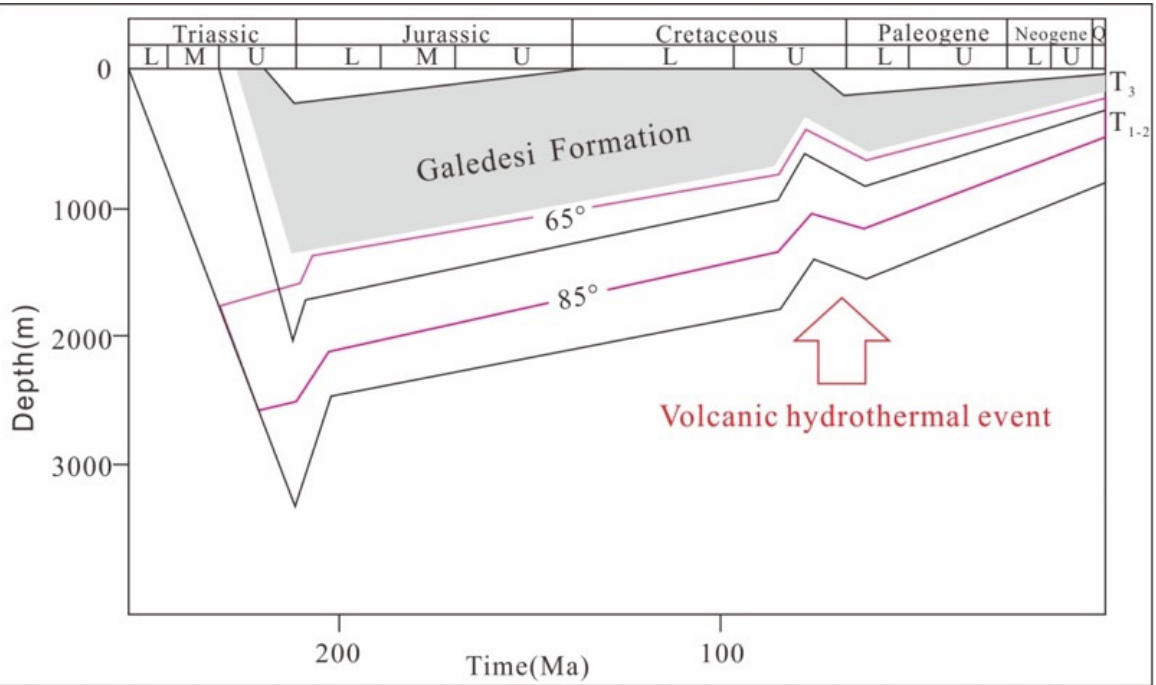
Figure 8. The burial history map of the Galedesi Formation shale in the study area.